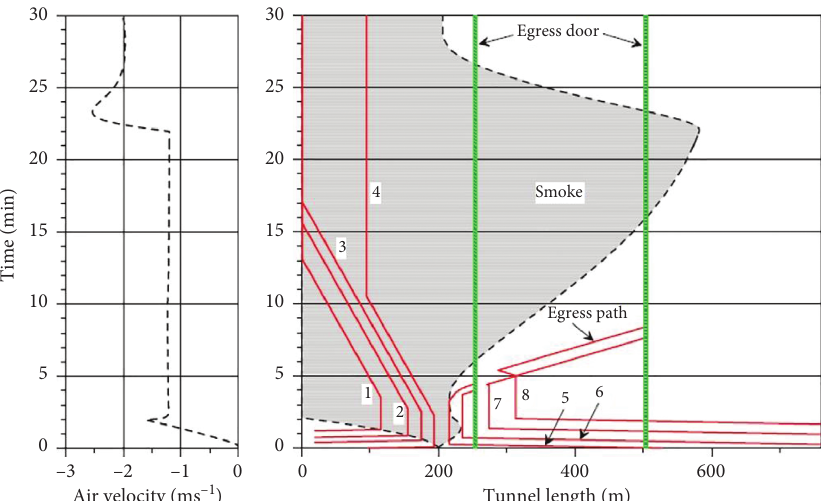
Figure 13: Graphical output of simulation of smoke propagation and escape paths [34].